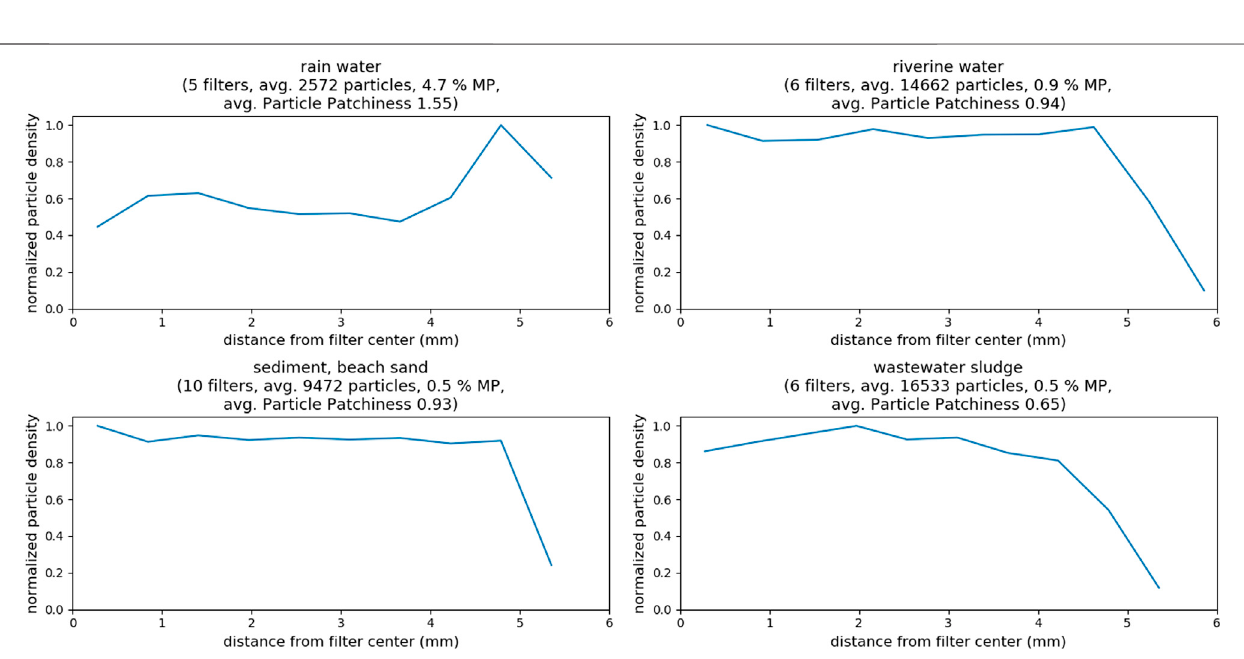
FIGURE 7 | Total particle density as function of distance from fi lter center for samples of different compartments, as well as determined particle patchiness. All fi ltrations were done on 10 × 10 mm silicon fi lters.